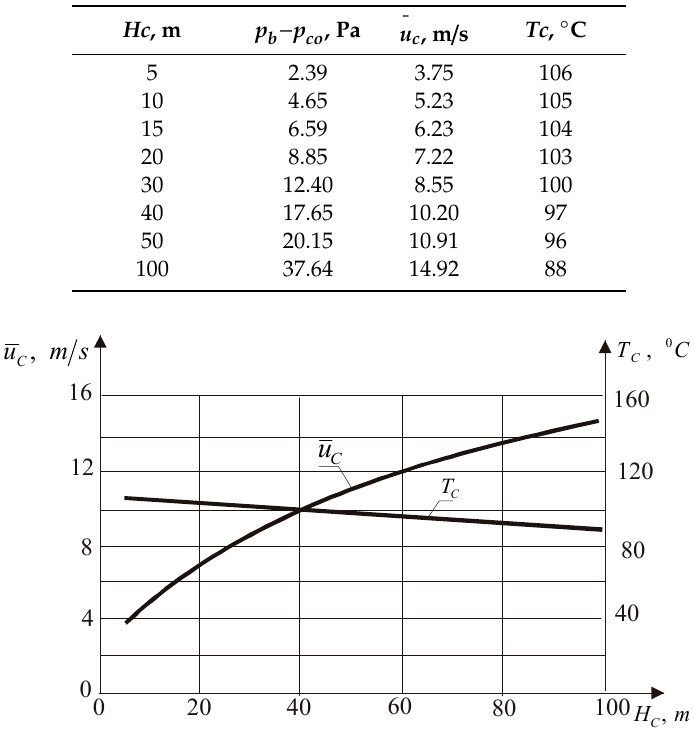
Figure 4. Dependence of air temperature (Tc) and velocity (uc) on the height of the chimney (H C ) for . To = 26 ◦ C, h = 0.1 m, R = 10 m, Rc = 0.2 m, q = 800 W / m 2 , α = 10 W / (m 2